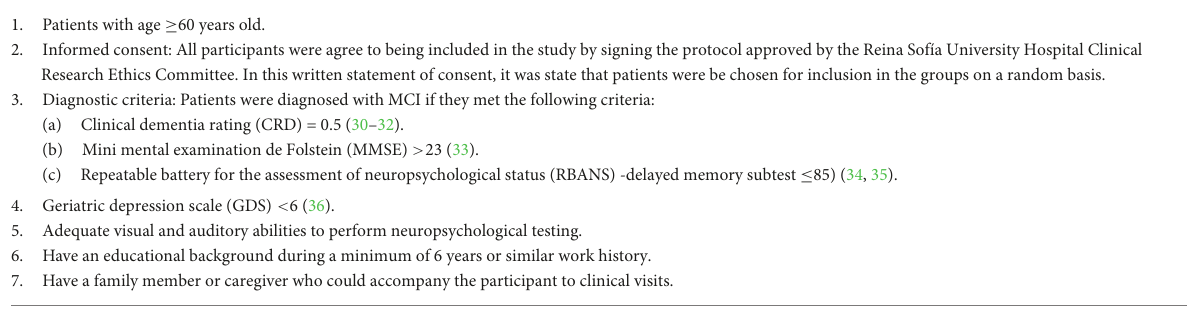
TABLE 1 Inclusion and exclusion criteria of study